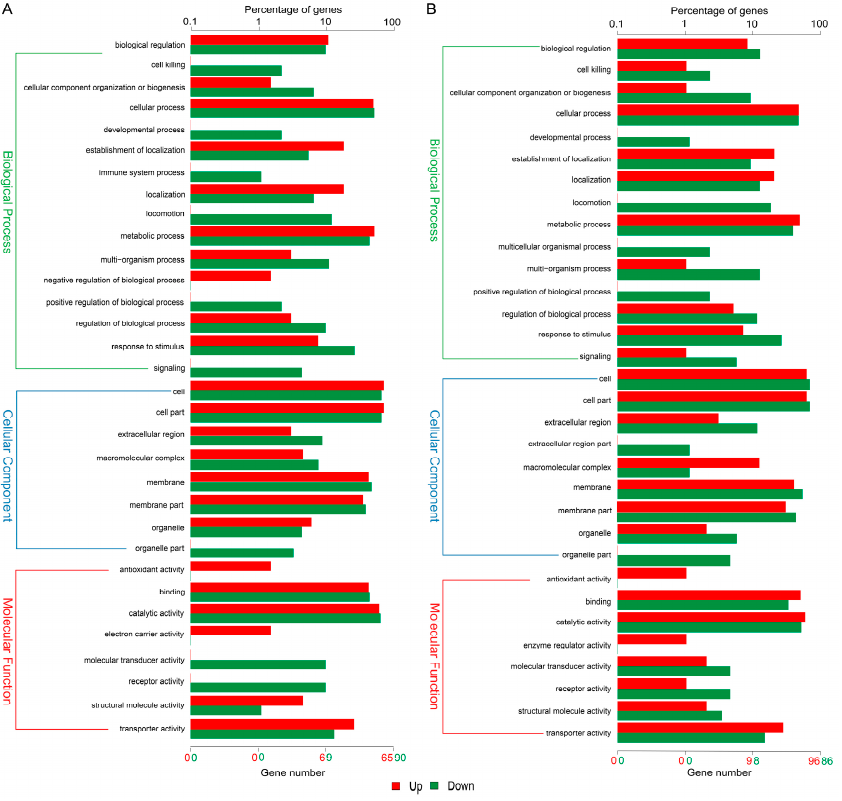
Figure 6. GO functional annotation for DEGs. ( A ) Res 50 vs. Res 0 groups. ( B ) Res 100 vs. Res 0 groups.